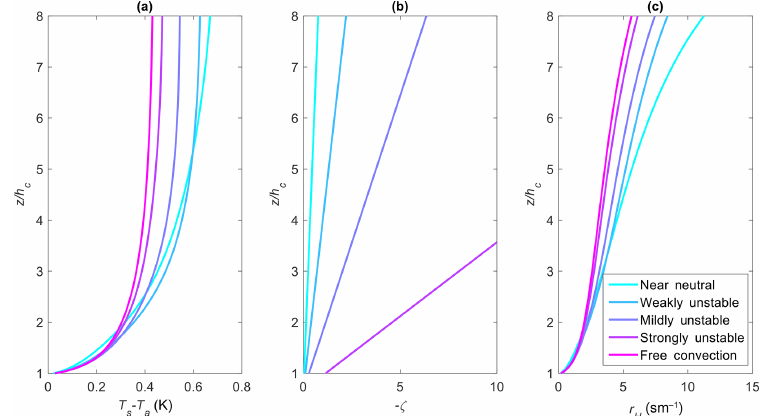
Figure 2. Aerodynamic resistance to the heat transfer exhibiting the canopy convector effect. (a) Difference between surface and air temper- ature ( T s − T a ); (b) stability parameter ζ ; (c) canopy aerodynamic resistance ( r H